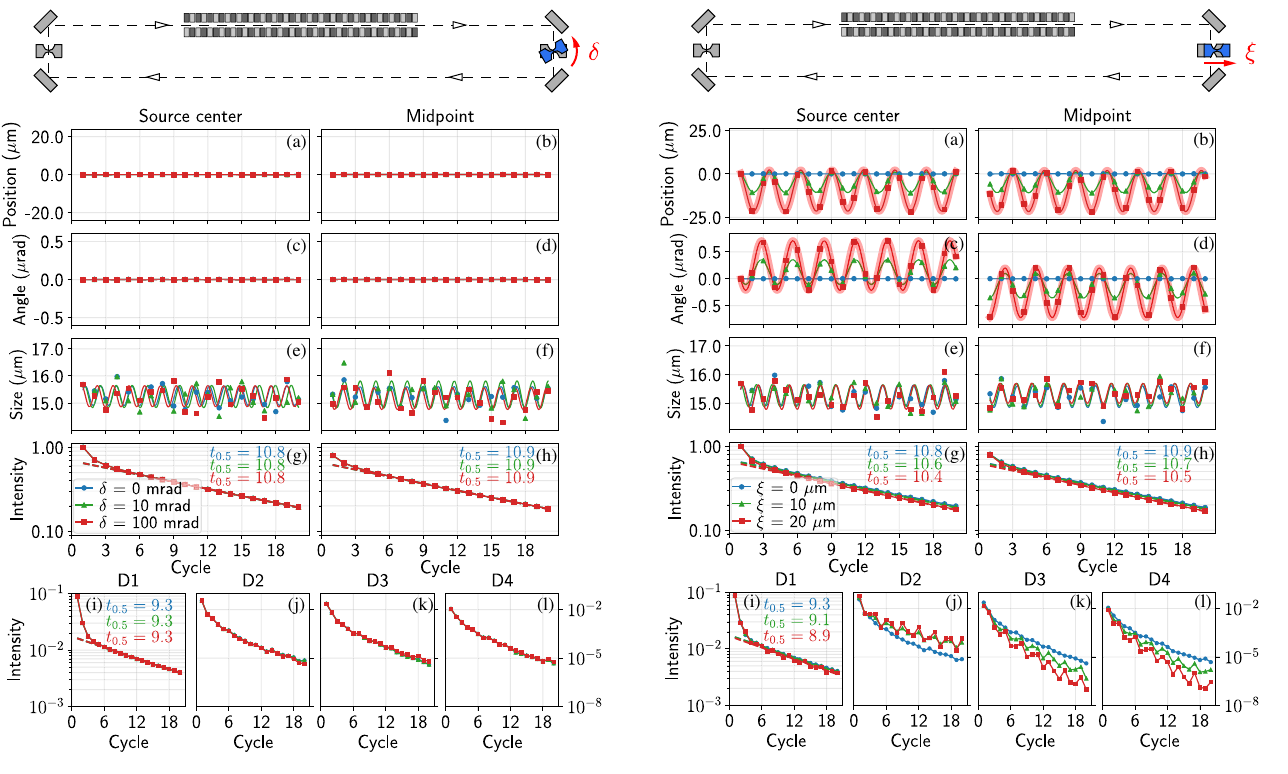
FIG. 17. Simulation results of x-ray beam dynamics in the four- crystal generic cavity with yaw angle error δ at lens L 1 .